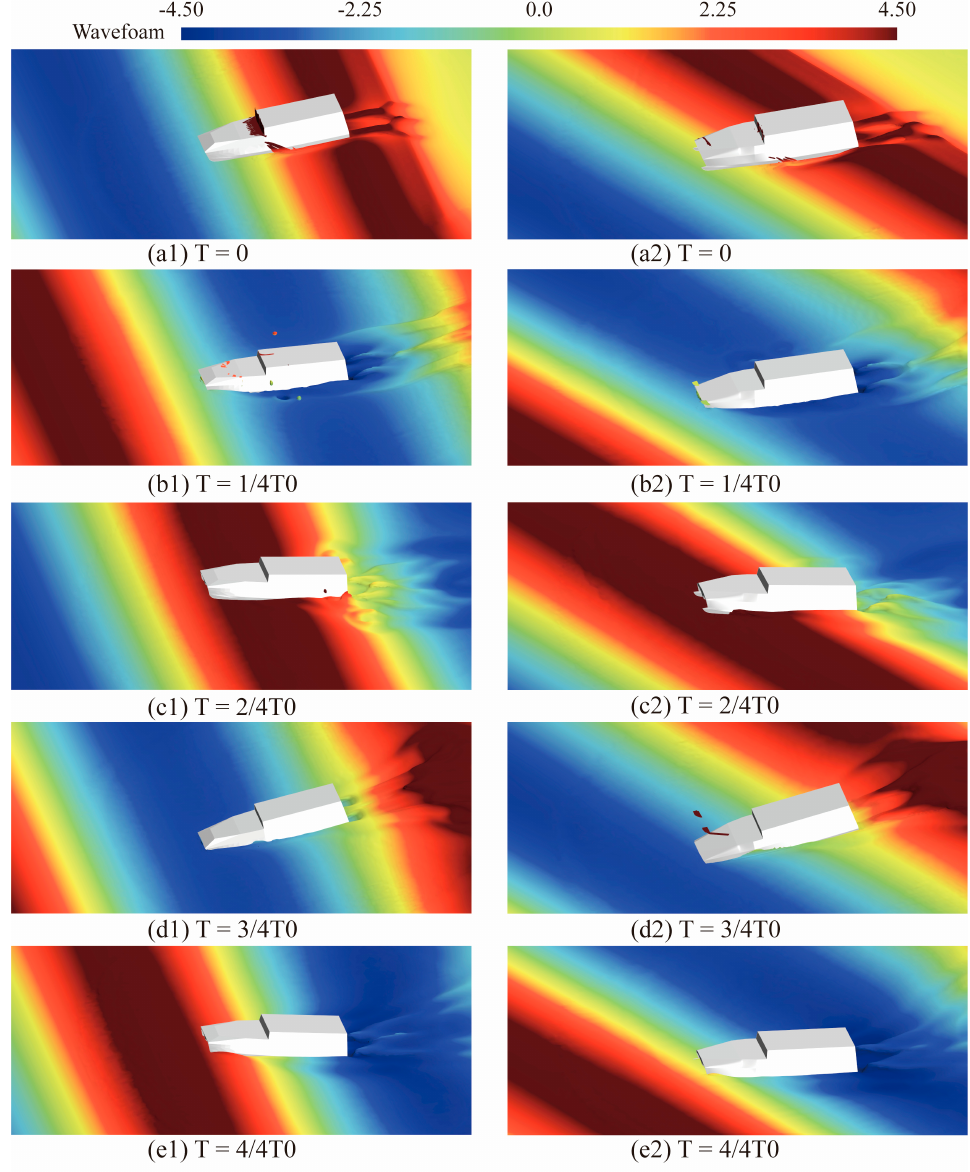
Figure 27. Free surface waveform and USV three-dimensional attitude at 7 level sea state (( left ): 0 ◦ wave direction; ( right ): 30 ◦ wave